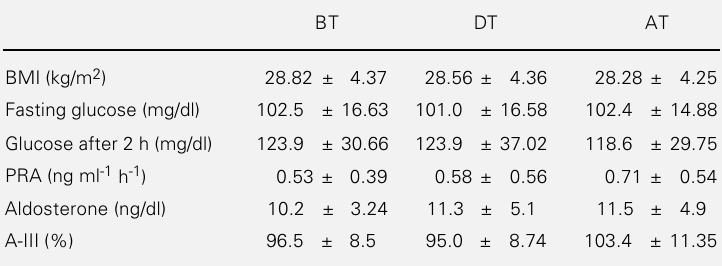
Table 2 - Lack of effect of percutaneous 17ß-estradiol on body mass index (BMI), fasting glucose, plasma renin activity (PRA), aldosterone and plasma antithrombin III